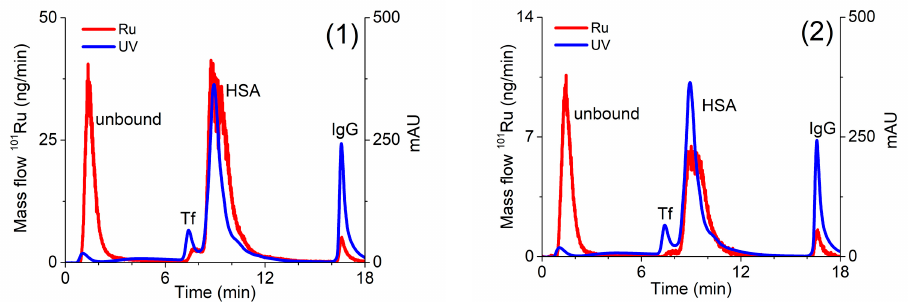
Figure 4. Two-dimensional separation of Ru species in serum sample spiked with complexes ( 1 ) (4.14 µ g / mL Ru) or ( 2 ) (0.838 µ g / mL Ru). Speciation analysis consisted of separation on the CLC monolithic column (24 h after incubation in 5-times diluted serum samples) and on-line UV spectrometry (278 nm) and ICP-MS detection. Ru mass flow is based on measurement of isotope ratios m / z 99 and 101.